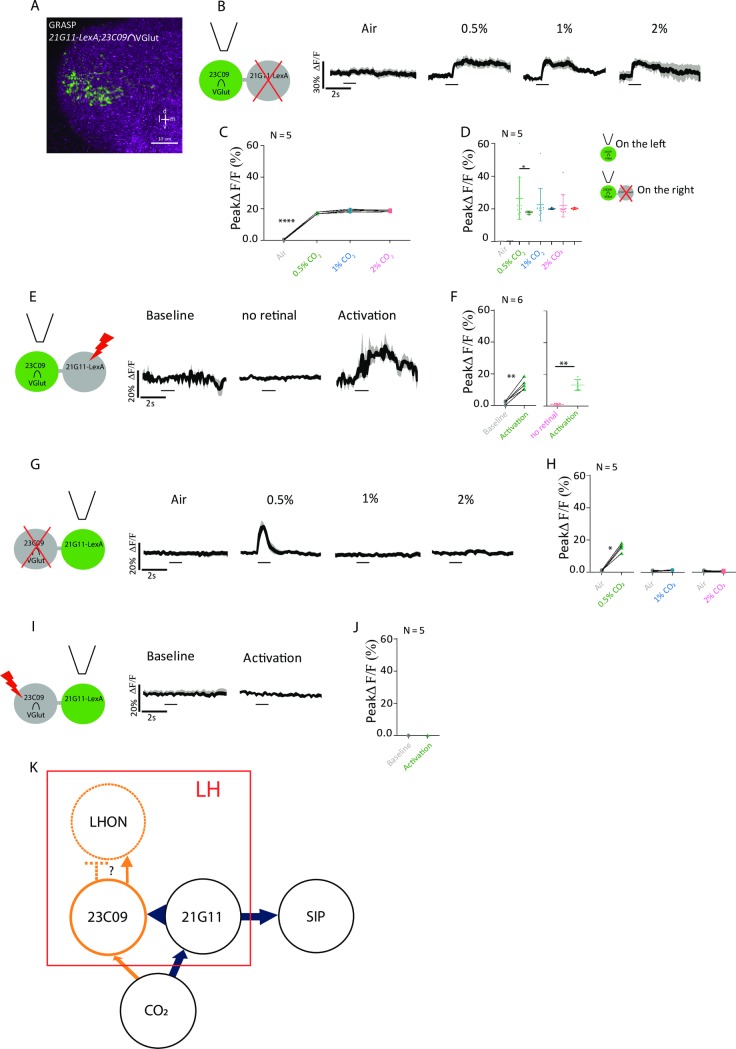
21G11-LexA neurons are presynaptic to 23C09∩VGlut neurons.(A) LH showing GRASP, a measure of contact between the membranes of neurons, in 21G11-LexA and 23C09∩VGlut. (B) Schematics of the experiment and calcium response at the LH, using GCaMP6m, of 23C09∩VGlut neurons to air, 0.5%, 1%, and 2% of CO2 while 21G11-LexA neurons are silenced by expression of Kir2.1. (C) Peak GCaMP6m intensity change after stimulation with air, 0.5%, 1%, and 2% of CO2. (D) Peak GCaMP6m intensity change between Fig 2F and Fig 3C after stimulation with air, 0.5%, 1%, and 2% of CO2. (E) Schematics of the experiment and calcium response at the LH of 23C09∩VGlut during baseline, activity without retinal, and upon activation with 720 nm light of 21G11-LexA driving expression of Chrimson. (F) Peak GCaMP6m intensity change of 23C09∩VGlut during baseline, activity without retinal, and upon activation with 720 nm light of 21G11-LexA driving expression of Chrimson. (G) Schematics of the experiment and calcium response at the LH, using GCaMP6m, of 21G11-LexA neurons to air, 0.5%, 1%, and 2% of CO2 while 23C09∩VGlut neurons are silenced by expression of Kir2.1. (H) Peak GCaMP6m intensity change after stimulation with air, 0.5%, 1%, and 2% of CO2. (I) Schematics of the experiment and LH activity of 21G11-LexA upon activation of 23C09∩VGlut neurons, expressing Chrimson, with 720 nm light. (J) Peak GCaMP6m intensity change of 21G11-LexA during baseline and activation with 720 nm light of 23C09∩VGlut driving expression of Chrimson. (K) Proposed model of the LHNs processing CO2 information. Elements in dashed lines are hypothetical. For (B), (E), (G), and (I), the average time course of GCaMP6m intensity change is shown. The black bar indicates the time of the stimulus. Scale bar = 10 μm. *p < 0.05, **p < 0.01, ****p < 0.0001. All p values are calculated with Wilcoxon signed-rank test. d, dorsal; GFP, green fluorescent protein; GRASP, GFP reconstitution across synaptic partners; l, lateral; LH, lateral horn; LHN, LH neuron; LHON, LH output neuron; m, medial; SIP, superior intermediate protocerebrum; v, ventral.